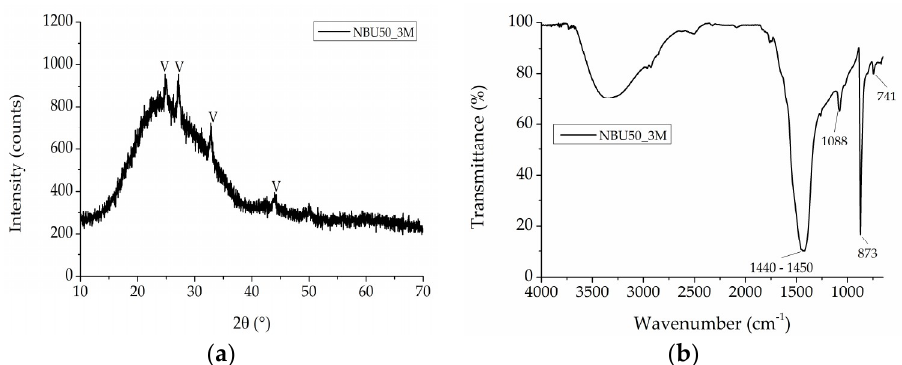
Figure 7. NBU after three months at 50% RH (NBU50_3M): ( a ) XRD pattern and ( b ) μFT-IR spectrum. XRD peak assignments: V, vaterite.